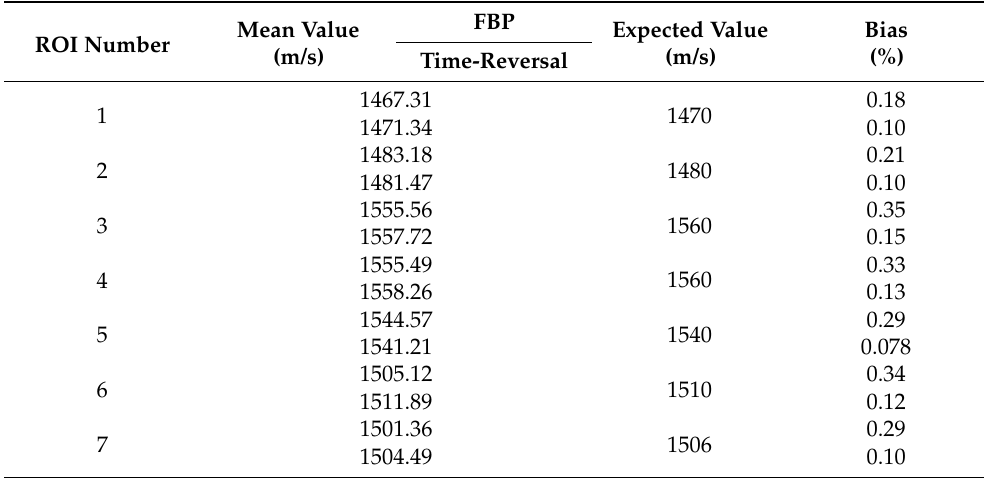
Figure 9. Reconstructed attenuation coefficient distribution. ( a ) Original attenuation coefficient distribution. ( b ) Recon- structed through time-reversal. ( c ) Reconstructed through FBP. Table 4. Mean values, expected values, and bias at the ROIs shown in Figure 8 for sound speed distributions.